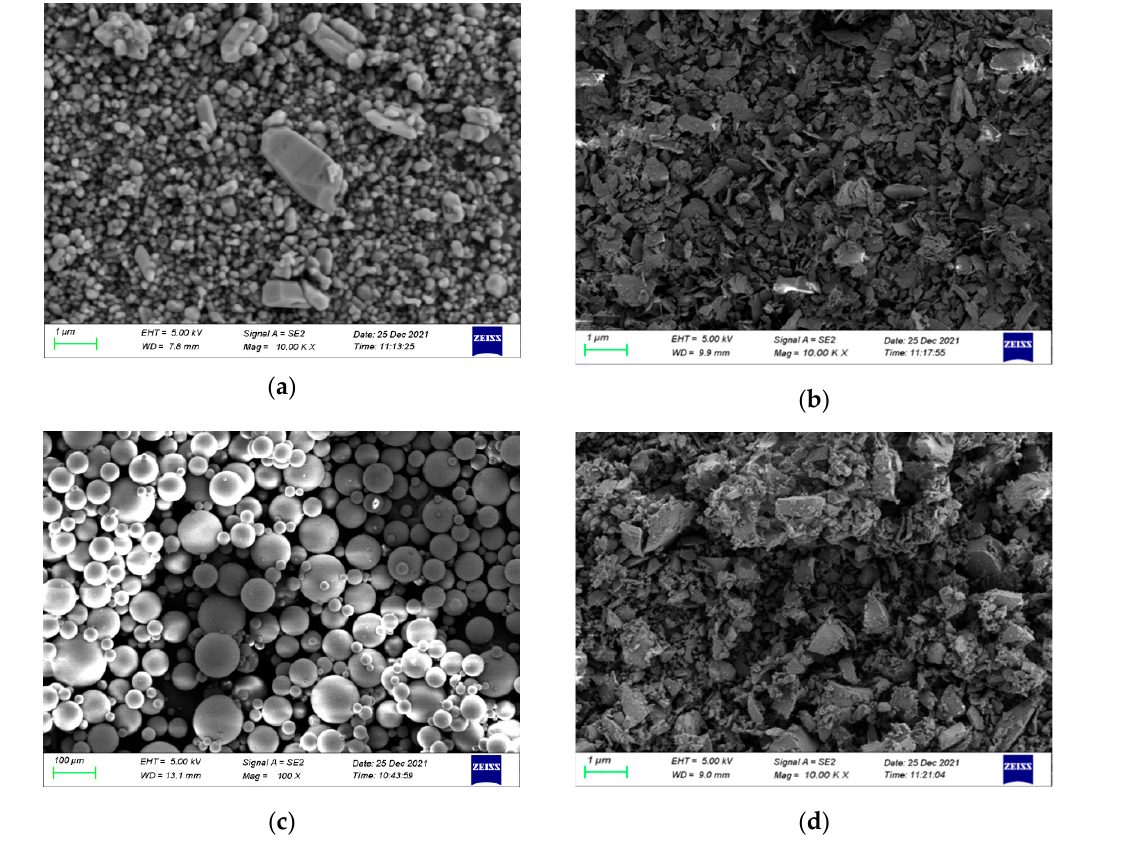
Figure 1. Micromorphology of functional fillers. ( a ) Titanium dioxide. ( b ) Silicon dioxide. ( c ) Hollow glass microspheres. ( d ) Sericite powder.